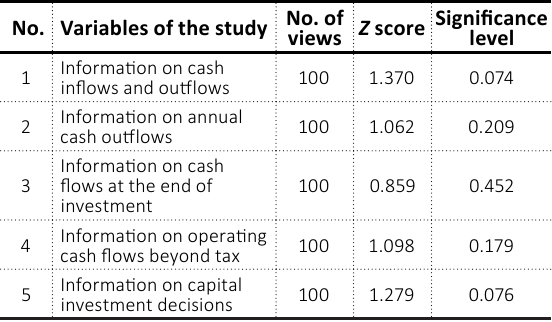
Table 6. Normal distribution test (one-sample Kolmogorov-Smirnov